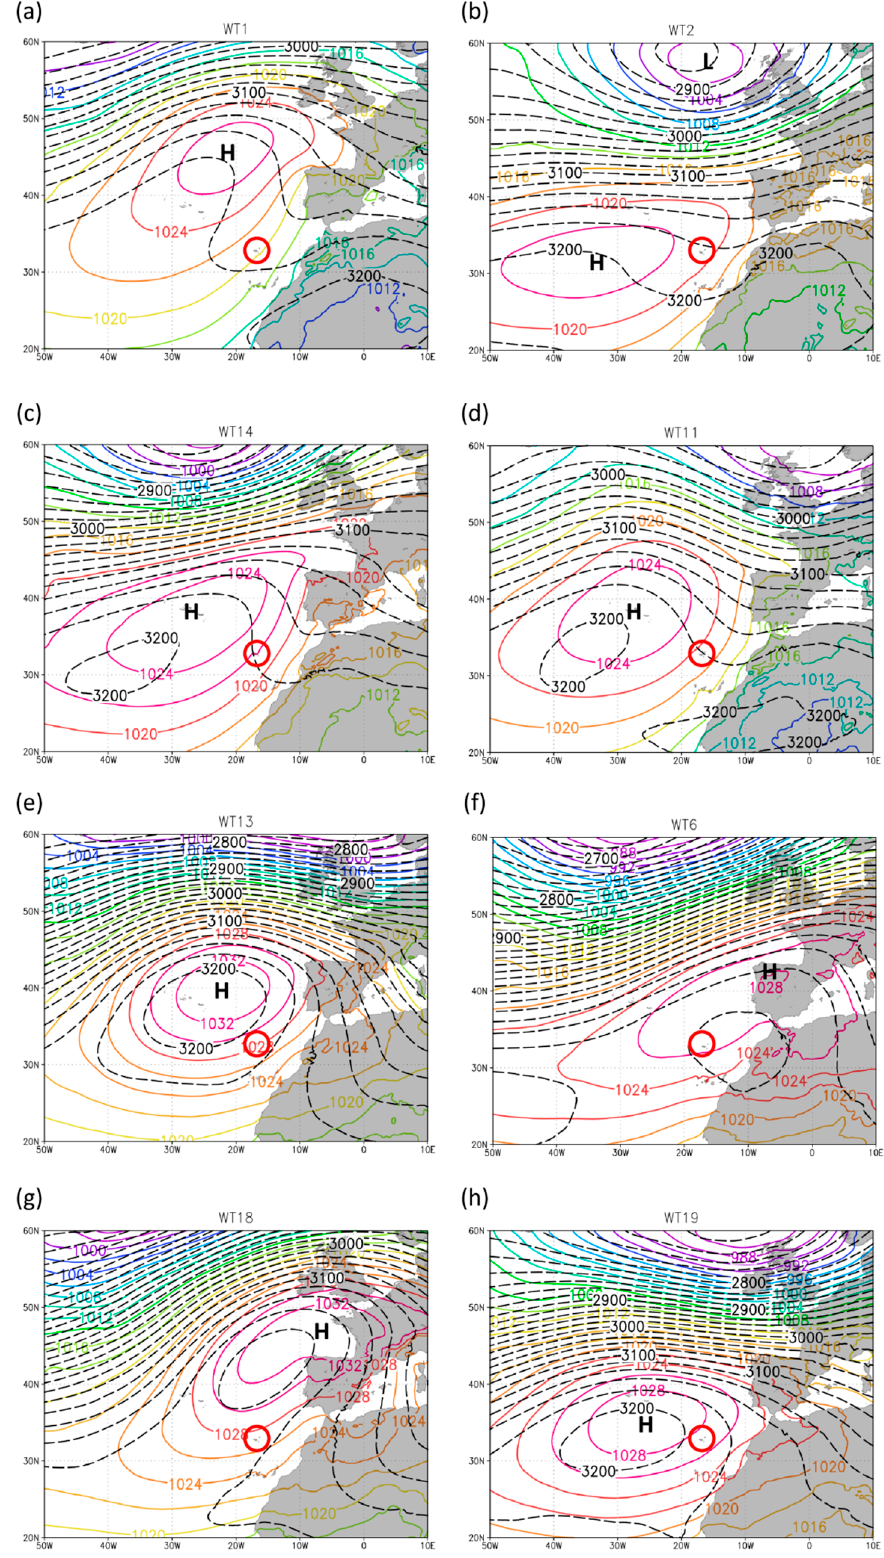
Figure 5. ( a–h ) Composites of the daily mean sea level pressure (solid contours) and 700 hPa geopotential height (dashed contours) over the eastern North Atlantic and adjacent landmasses for the weather types (WT) most favourable to take-off/landing restrictions at the Madeira Airport. (a) WT1, (b) WT2, (c) WT14, (d) WT11, (e) WT13, (f) WT6, (g) WT18 and (h) WT19. The location of the Madeira Island is indicated by the red circles.